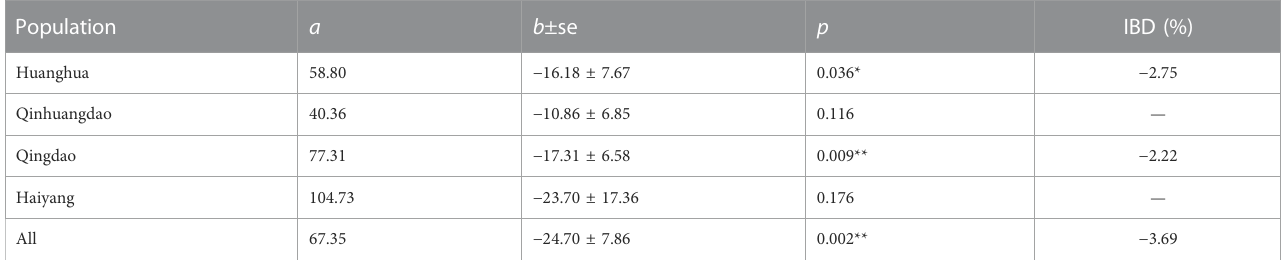
TABLE 5 Results from regressions of body weight on F and IBD expressed as percent change in phenotype per 10% increase in F. Population a b